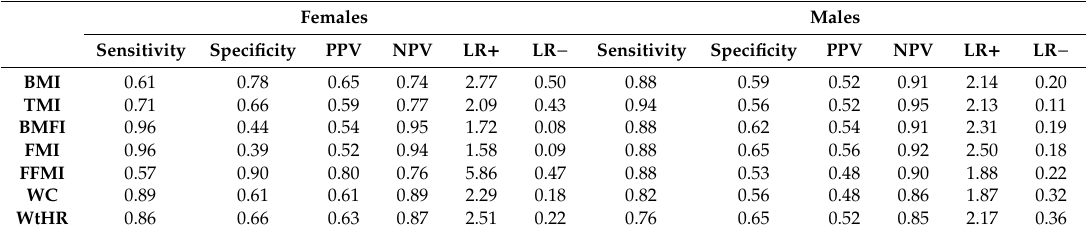
Table 4. Sensitivity, specificity, positive (PPV) and negative predictive values (NPV) and the likelihood ratio (LR) for each index for identifying MetS. See the text for an explanation of the results. Females Males Sensitivity Specificity